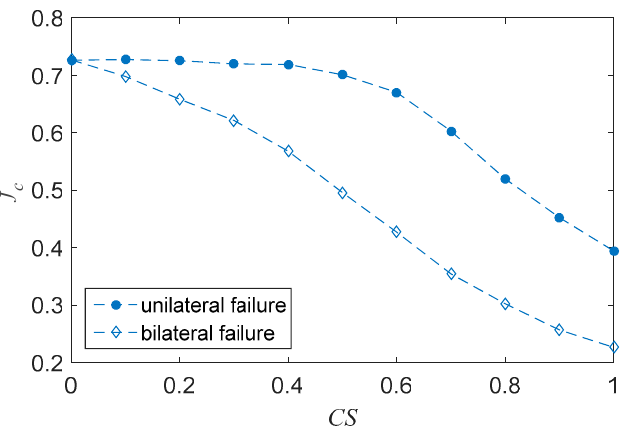
Figure 4. Relationship between collapse threshold f c and coupling strength ( CS ) on both unilateral and bilateral failure modes.